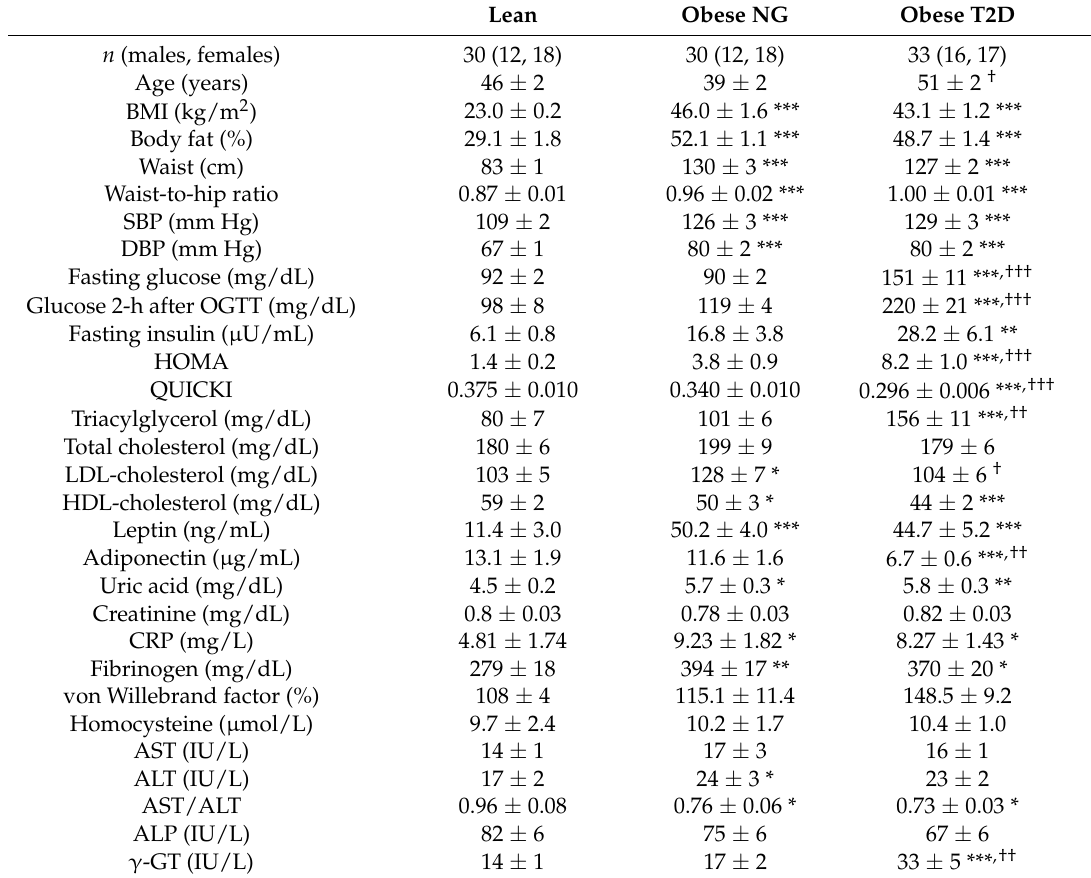
Table 1. Anthropometric and biochemical characteristics of subjects included in the study. Lean Obese NG Obese T2D n (males,